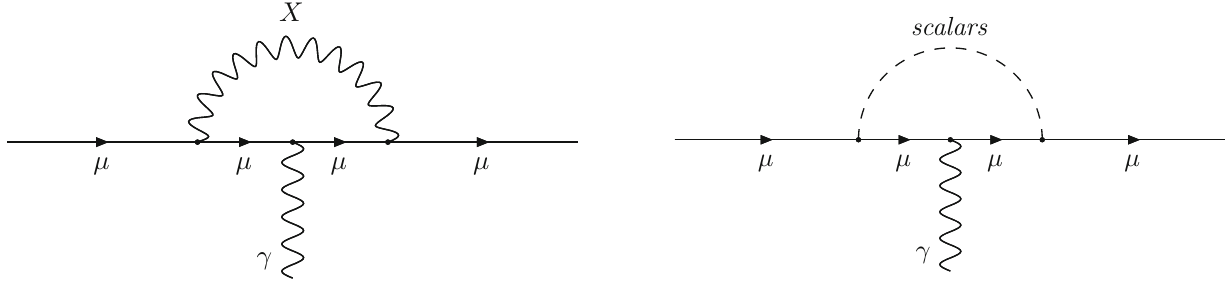
Fig. 3 Feynman diagrams for the muon anomalous magnetic moment with the new contributions of the gauge boson X and the scalars